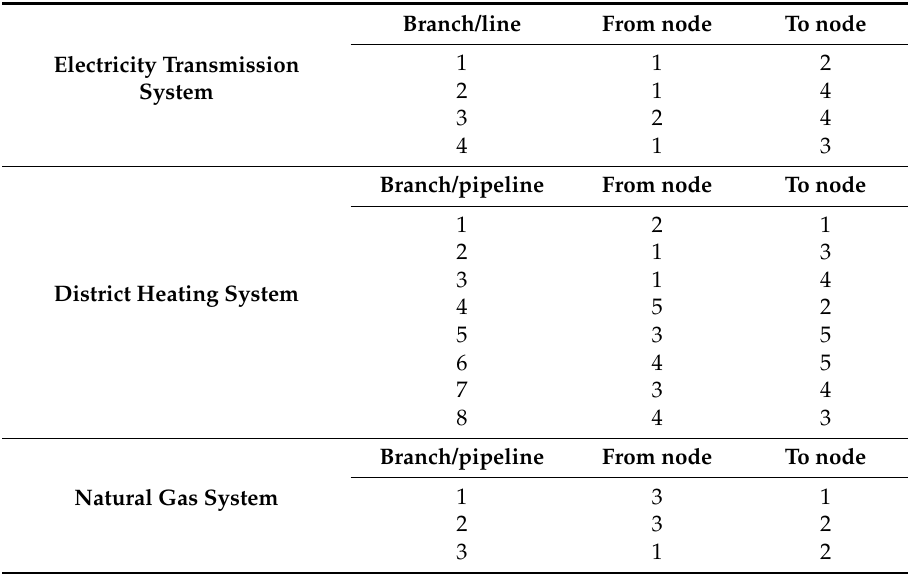
Table 1. Topology information of the IES